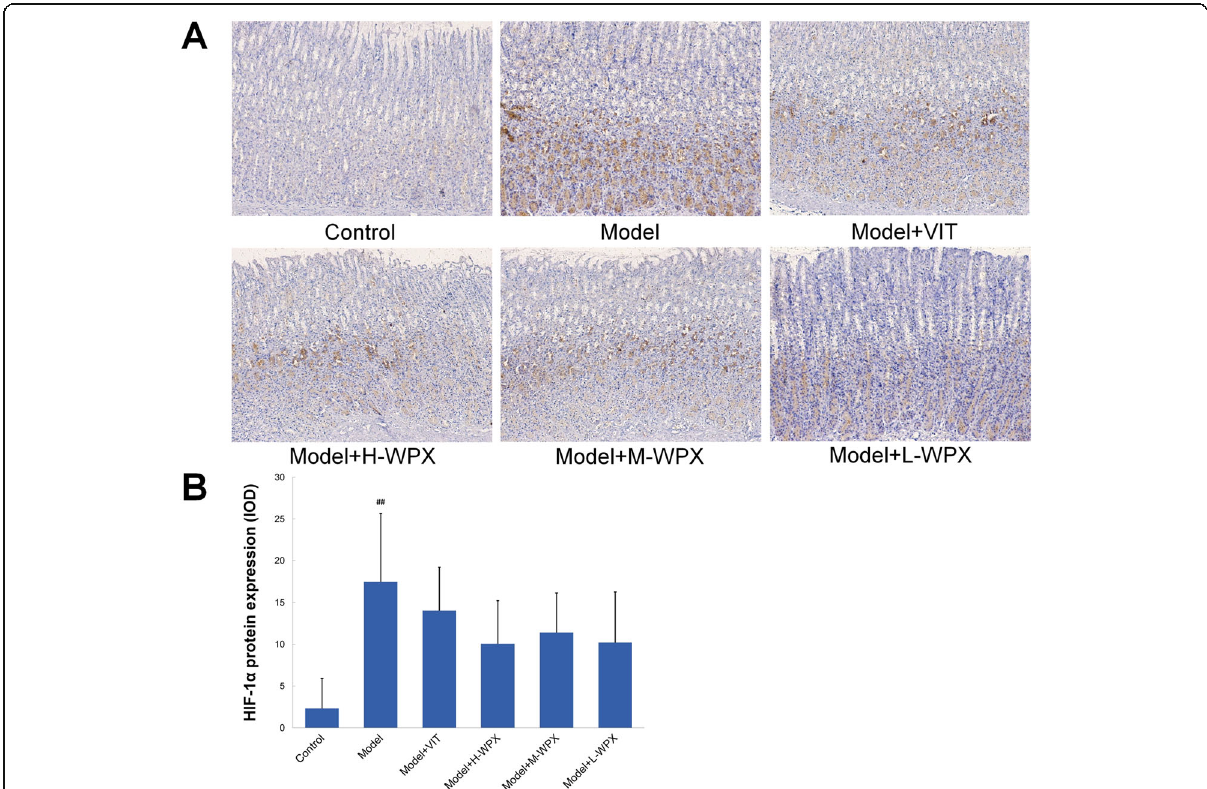
Fig. 7 Effect of WPX on HIF-1 α protein expressions in gastric epithelium. a HIF-1 α protein expressions in gastric epithelium from different groups. b IOD scores of HIF-1 α protein levels. The results are expressed as mean ± SD ( n = 9 in each group). Note: ## P < 0.01, vs Control. (IHC,